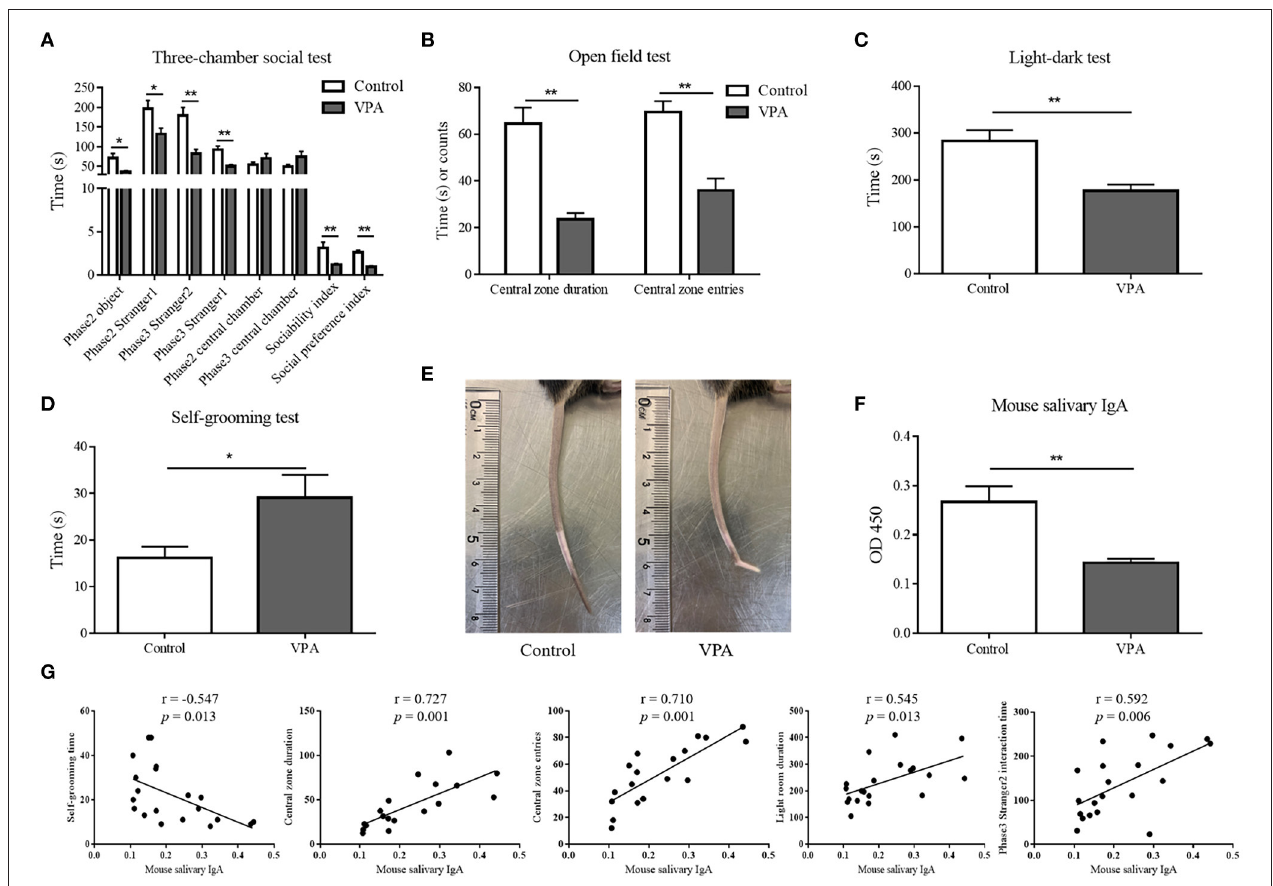
FIGURE 4 | The salivary immunoglobulin A (IgA) content in mouse saliva samples and its correlation with the mouse autistic-like behaviors. (A) In the three-chamber social performance test, the durations of valproate acid (VPA) mice and control mice interacted with the object, Stranger 1 and Stranger 2 in phase 2 and phase 3, and the time they spent in each chamber were recorded. According to which the sociability index and social preference index were calculated ( n = 9–11 per group, Mann-Whitney U-test and Student’s t -test). (B) The time VPA mice and control mice spent in the central zone and the frequency of them entering the central zone